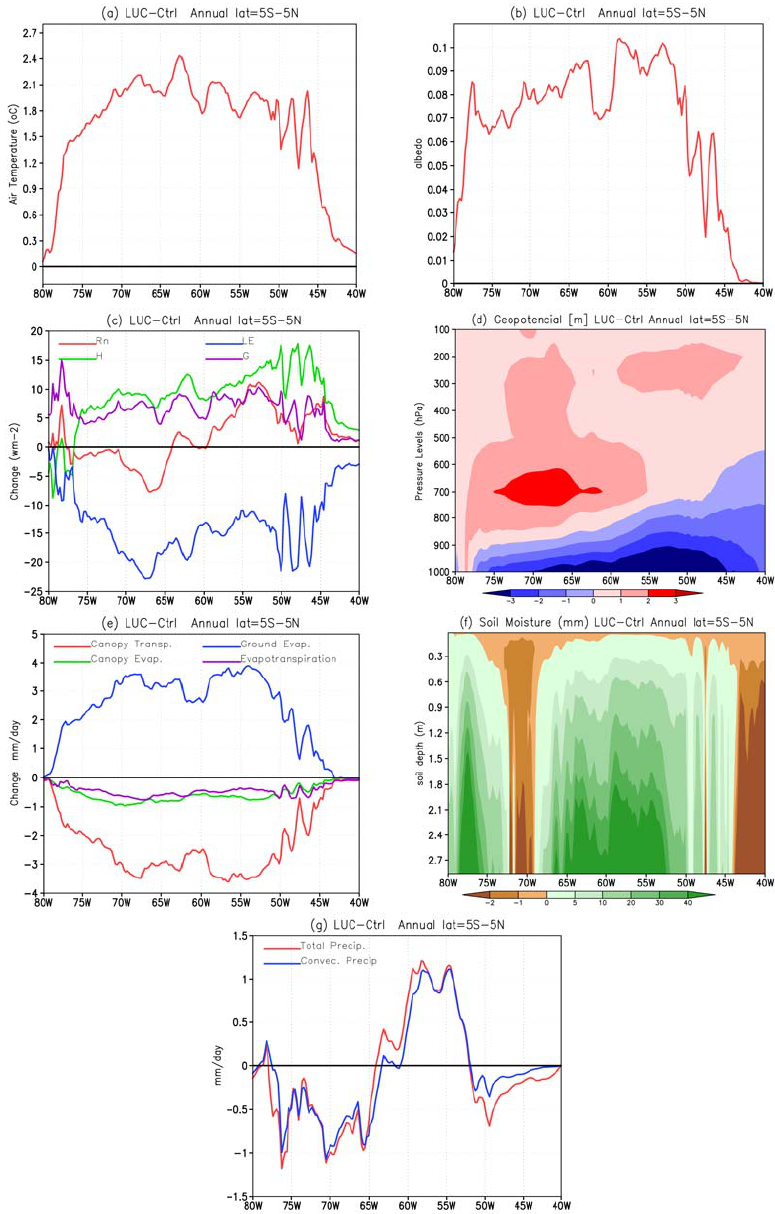
Figure 4. Cross section (5° S–5° N): ( a ) change in air temperature ( ° C); ( b ) change in albedo; ( c ) change in the energy budget components (w m − 2 ): net radiation (red line), sensible heat flux (green line), latent heat flux (blue line) and soil heat flux (purple line); ( d ) change in geopotential height (m); ( e ) change in the evapotranspiration components (mm day − 1 ): ground evaporation in blue, canopy transpiration in red, canopy evaporation in green and total evapotranspiration in purple; ( f ) change in soil moisture (mm) and ( g ) change in precipitation (mm day − 1 ): total precipitation in red and convective precipitation in blue.